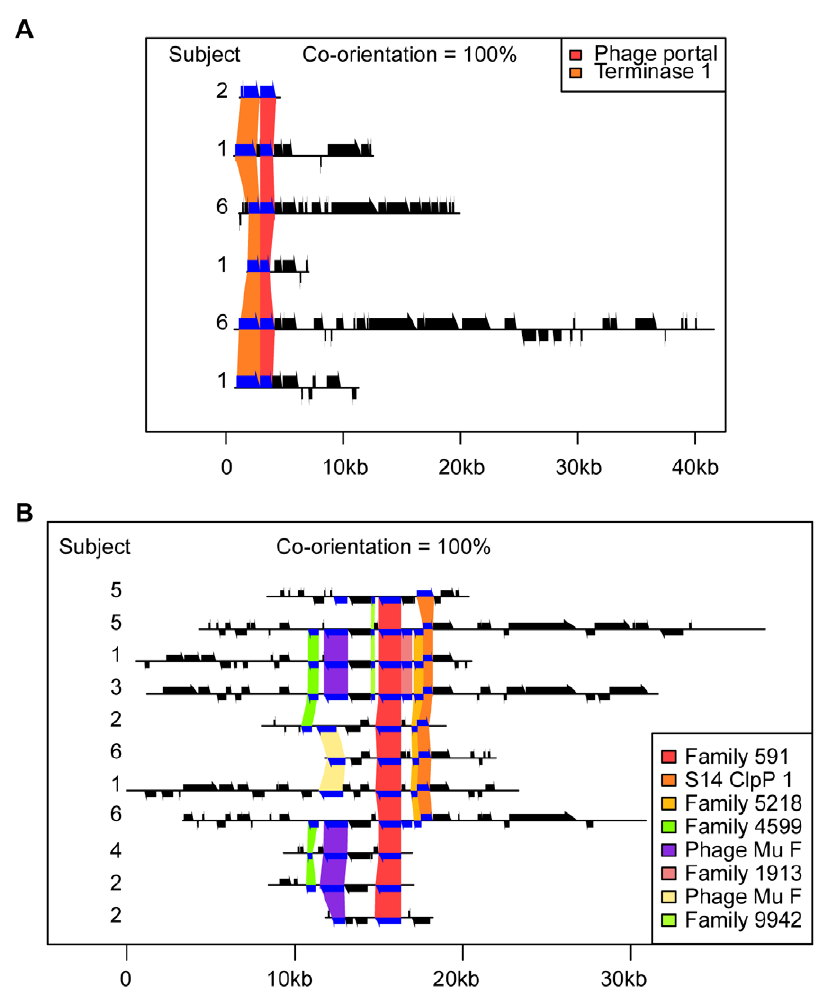
Figure 4. Two examples of phage cassettes. Contigs are shown as horizontal black lines, ORFs on those contigs are shown by black arrows above and below those lines, and the organization of those ORFs into protein-coding families is shown with colored boxes. The subject that each contig was assembled from is shown on the left of each panel. When a protein-coding family was functionally annotated according to its similarity with the CDD, that annotation is listed in the legend. Otherwise a unique identification number is shown (e. g. Family 591). The co-orientation score describes the proportion of gene pairs that, when occurring together on multiple contigs, do so in the same relative orientation.